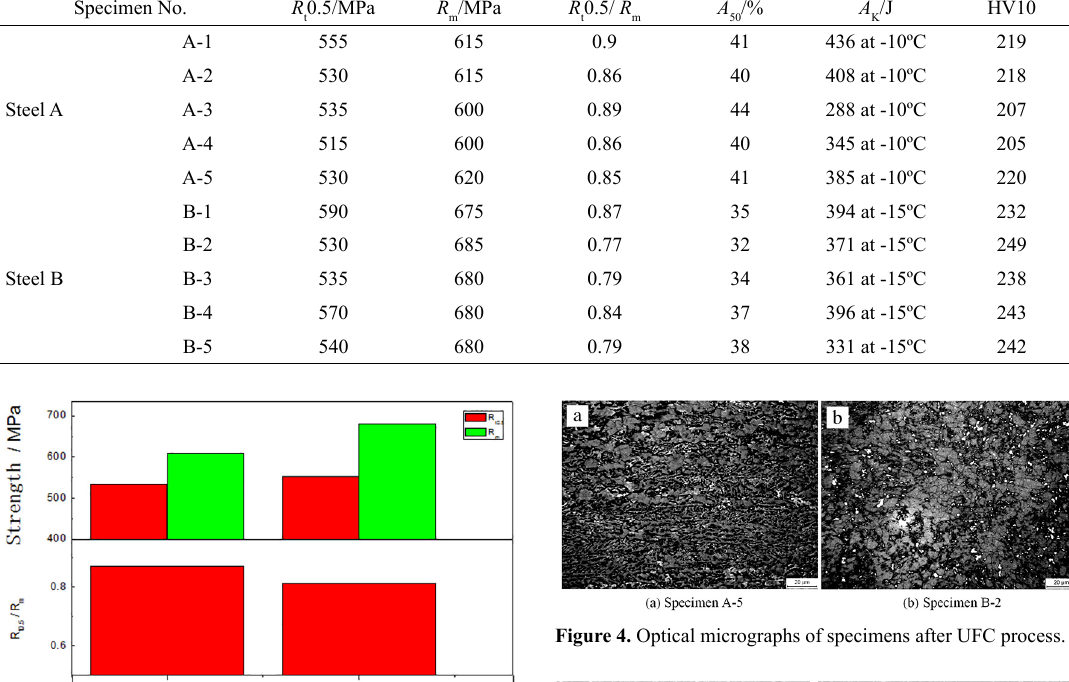
Table 2. Mechanical properties of the experimental steels. Specimen No.